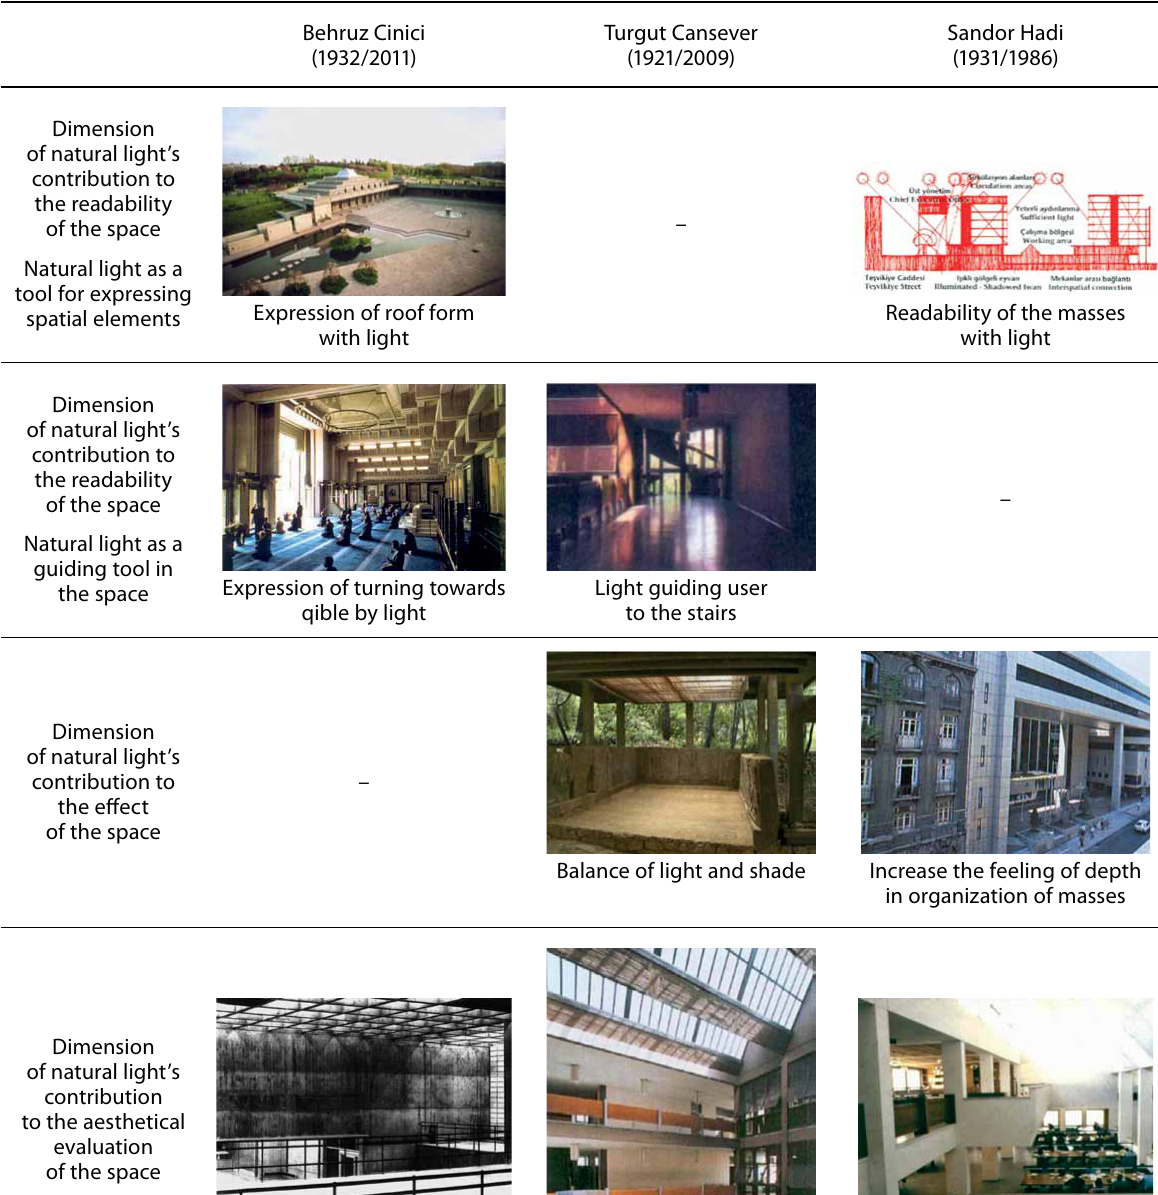
Table 2. Dimentions of natural light’s contribution to the identity of